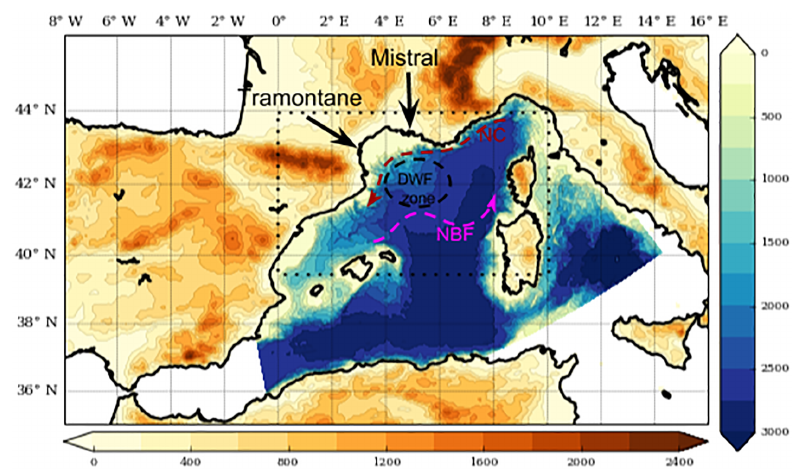
Figure 1. Full frame: spatial extension of the atmospheric model including topography (metres, horizontal colour bar, positive above sea level) and bathymetry (metres, vertical colour bar, negative below sea level) of the ocean model. The black dotted rectangle indicates the area studied. The red and magenta dotted lines represent oceanic surface circulation with the Northern Current (NC) and North Balearic Front (NBF), respectively. The black dotted circle indicates the dense water formation (DWF)